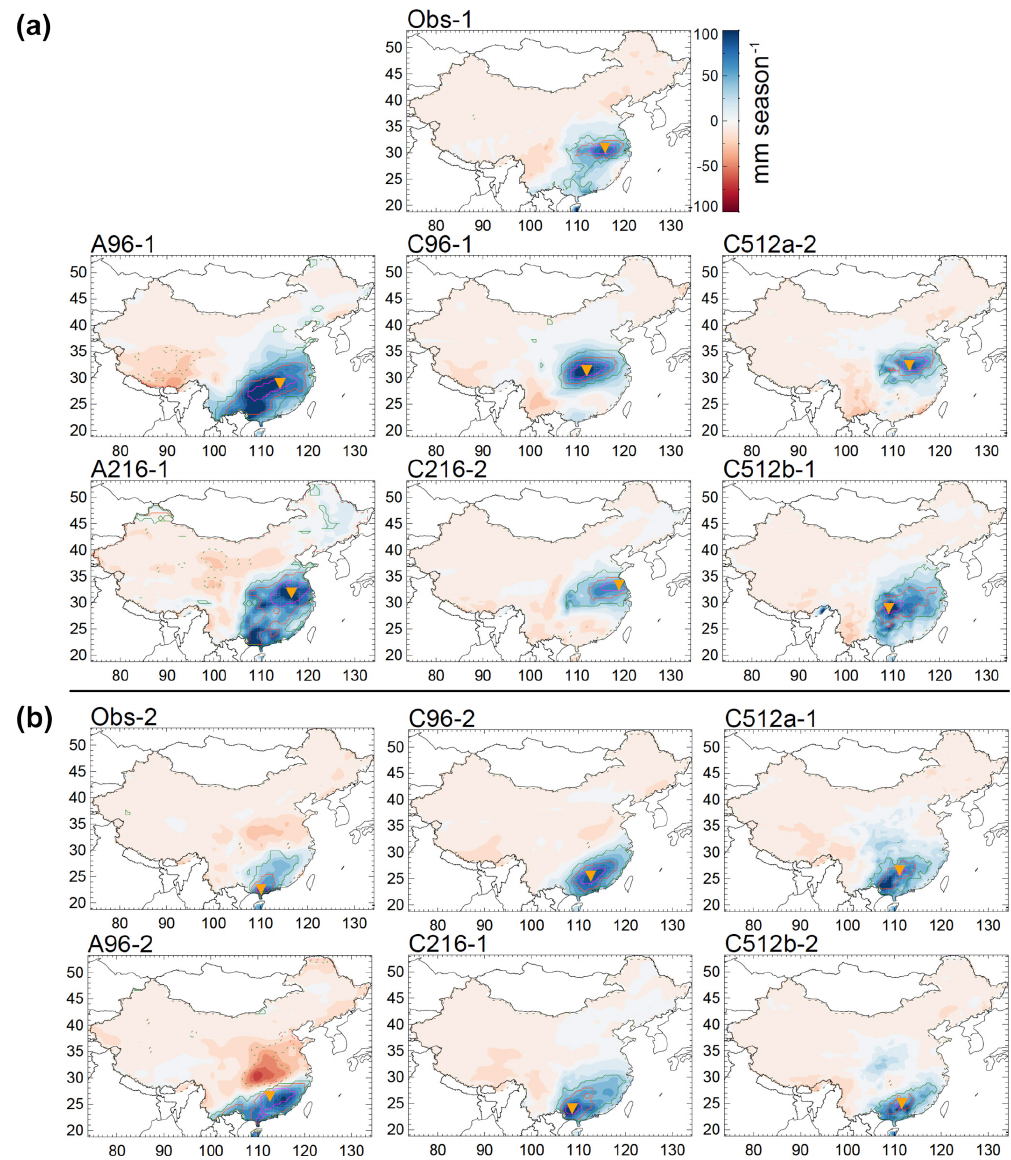
Figure 11. Shading shows regressions of SON precipitation against observed or simulated EOT time series. Also shown are positive (solid lines) and negative (dashed lines) correlations of the full (leading-order) or residual (higher-order) precipitation-anomaly time series with the EOT base point exceeding 0.8 (magenta), 0.6 (orange) and 0.4 (green). The EOT base point is marked by the orange inverted triangle. Panel (a) shows patterns that have a linear correlation coefficient exceeding 0.38 with the first observed pattern and (b) with the second observed pattern. The number next to the simulation name above each panel indicates the order of the simulated EOT pattern.